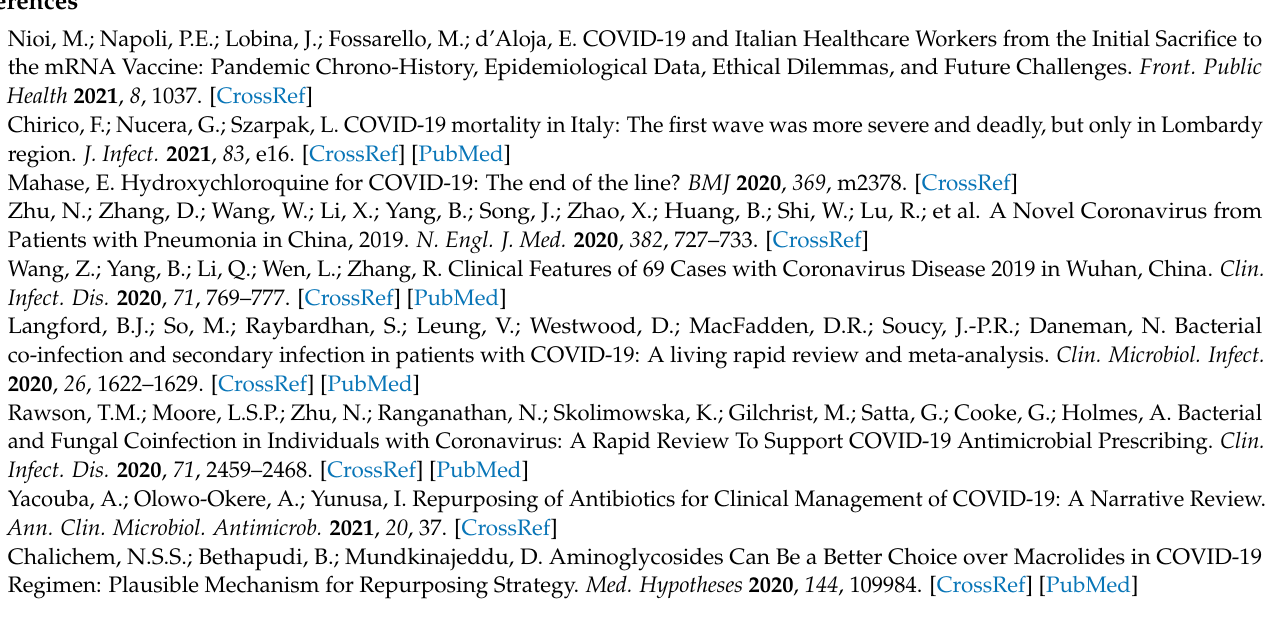
and COVID − patients. Supplementary Figure S2: Distribution of samples among clinical areas. Supplementary Figure S3: Number of strains isolated from COVID+ or COVID − patients hospitalized in the clinical areas under investigation. Supplementary Figure S4: Distribution of isolation sources among COVID+ and COVID − patients. Supplementary Figure S5: Alpha diversities of samples. Supplementary Figure S6: Correlations between the percentages of COVID+ and COVID − isolates resistances to the tested antibiotics and the number of new COVID-19 cases detected at the national level. Supplementary Figure S7: Number of new COVID-19 cases monitored at the national and provincial (Turin) levels. Other supplementary information associated with this study (provided as separated files): Supplementary Table S1: Details on the clinical bacterial isolates analyzed over this study. Supplementary Table S2: Details on the lists of antibiotics tested on the isolated species. Supplementary Table S3: Bacterial species isolated only from either COVID+ or COVID − patients. Supplementary Table S4: Wilcoxon-Mann-Whitney p values of the comparison between alpha diversities calculated for isolation sources. Supplementary Table S5: Distribution of bacterial isolates among COVID+ and COVID − patients and details on taxa. Supplementary Table S6: Distribution of resistances and susceptibilities among isolates. Supplementary Table S7: Species isolated before and/or during the COVID-19